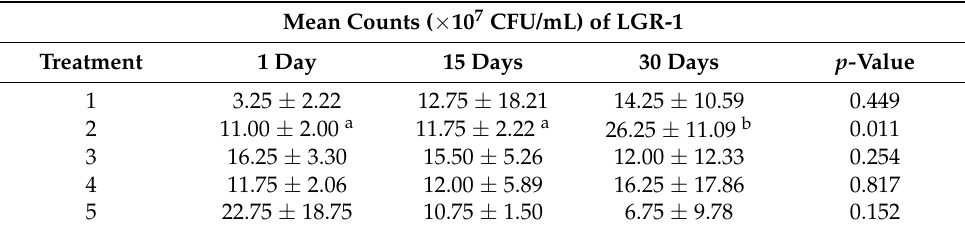
Table 2. Viable counts (mean ± SD) of LGR-1 in probiotic almond beverage supplemented with short-chain inulin and long-chain inulin following 1, 15, and 30 days of